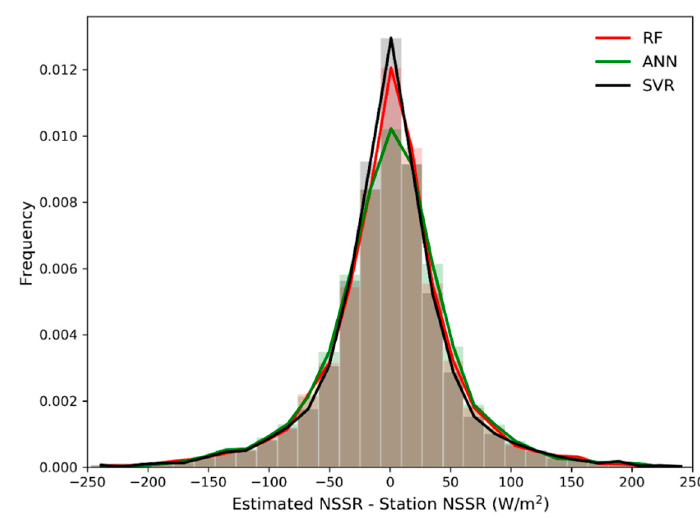
Figure 10. Histogram of the NSSR estimation error with the three machine learning algorithms.